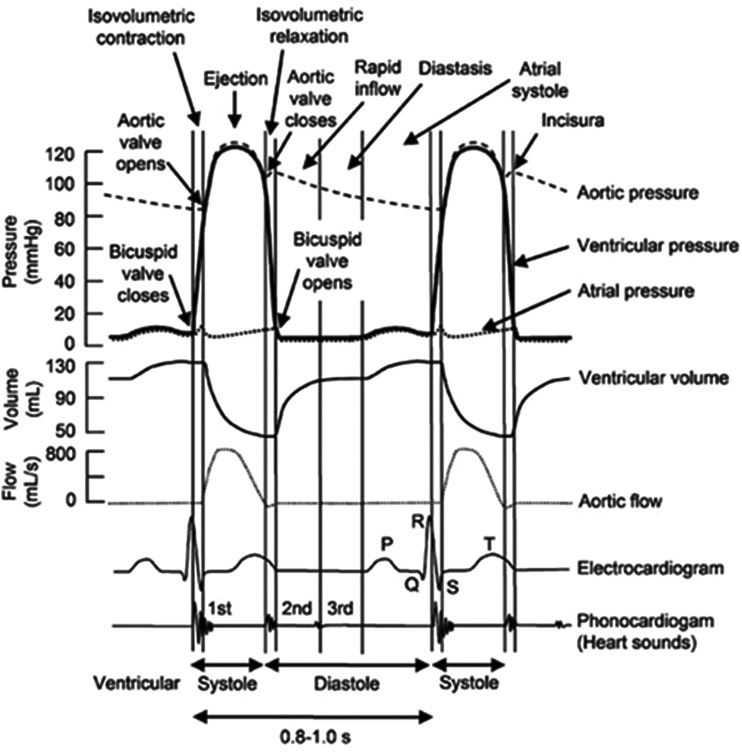
The variation of the pressure in a heart cycle [37]